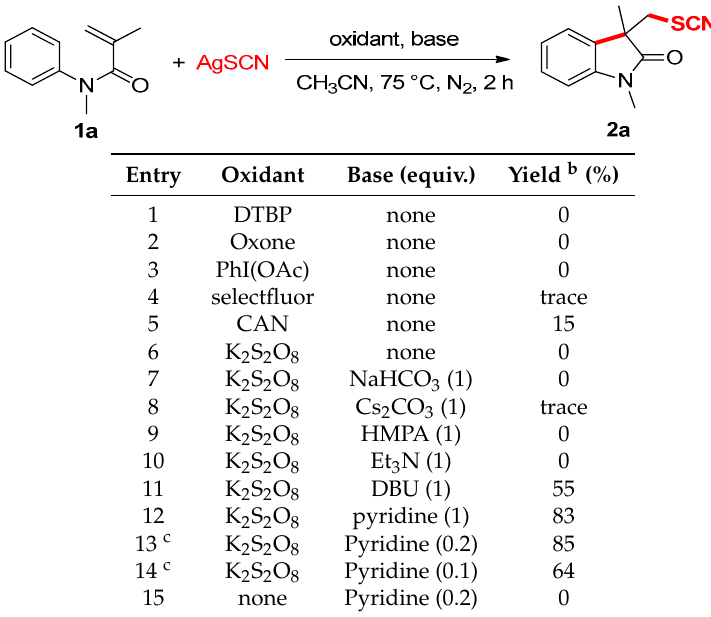
Table 1. Optimization of the Reaction Conditions a